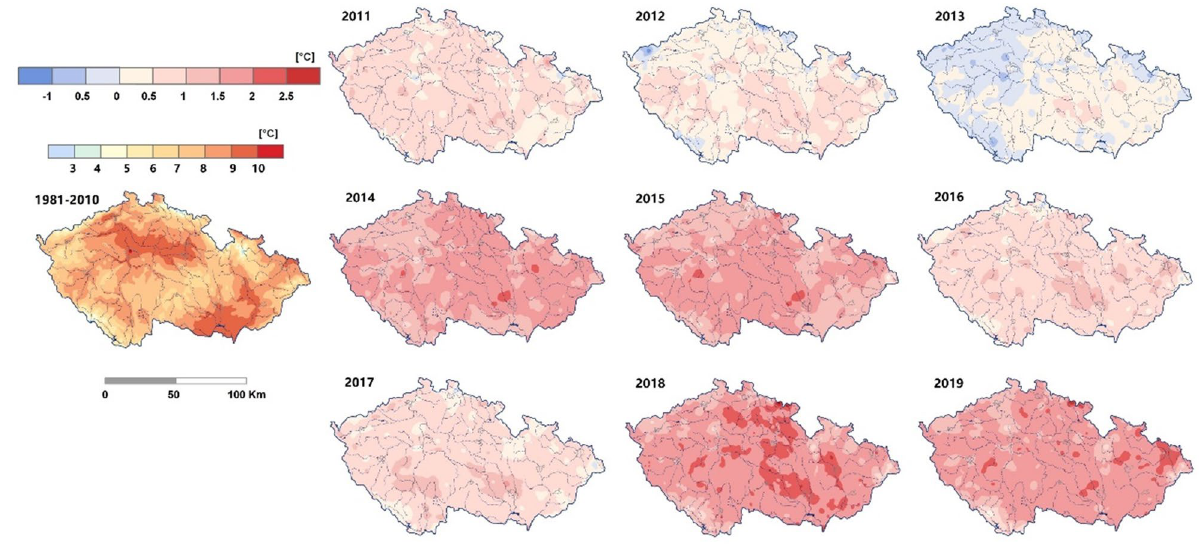
Figure 6. Comparison of the mean annual temperature of each year from 2011 to 2019 with the mean value of 1981–2010 ( modified from CHMI). The left map shows the average value of temperature of 1981–2010, the individual year’s precipitation was colored based on the difference with average value of 1981–2010. Temperature Precipitation Water